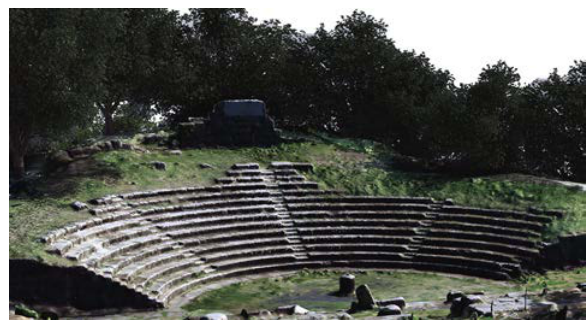
Figure 8. Render obtained from mesh model